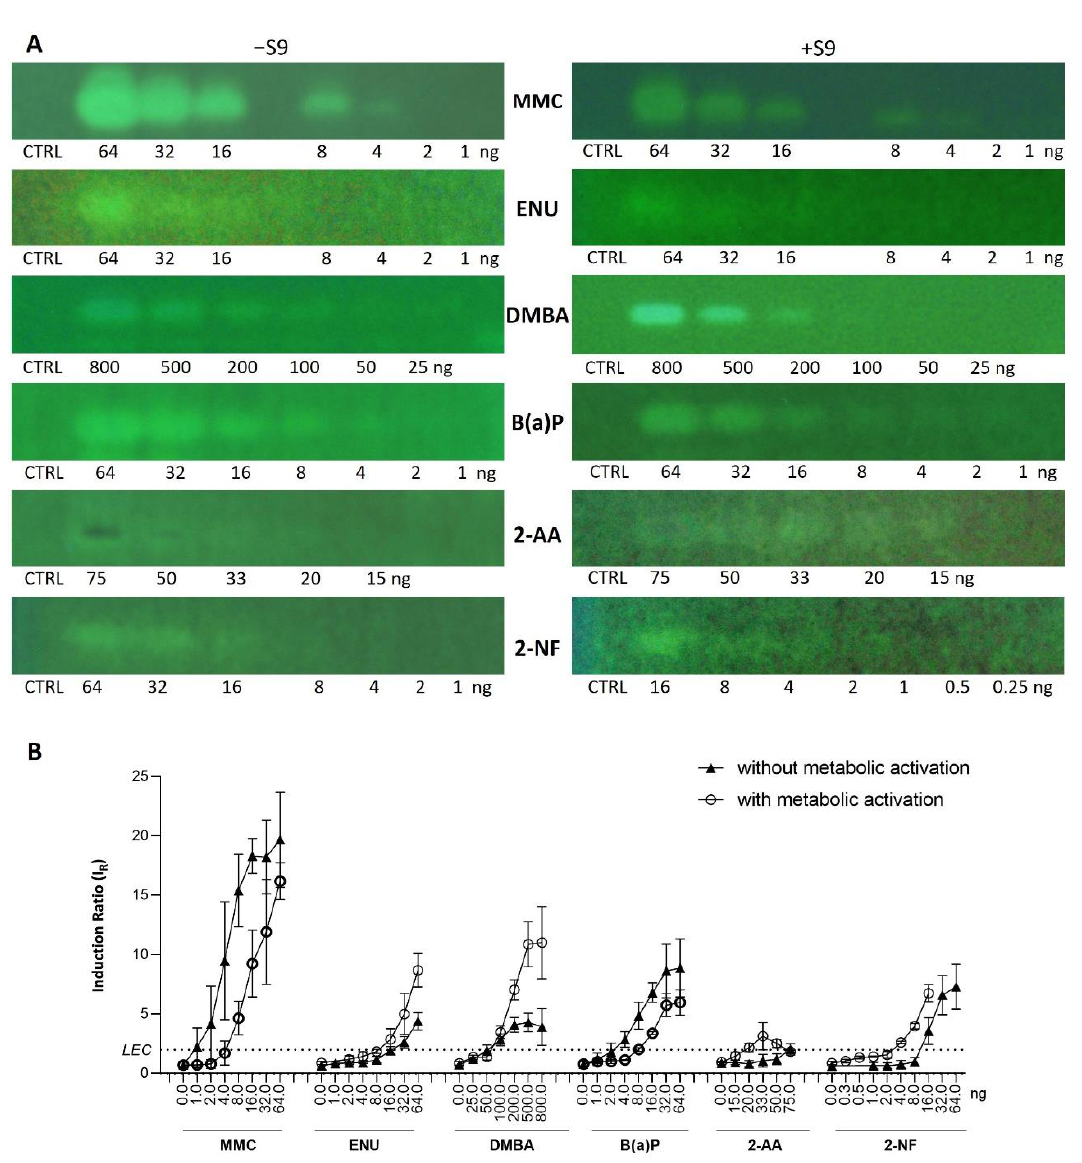
Figure 5. Dose – response study extended to 6 compounds (Table 1) in absence ( − S9) and presence (+S9) of metabolic activation, along with methanol solvent control (CTRL). ( A ) Bioautograms at FLD 254 nm (region of interest shown) and ( B ) dose – response curves with LECs (black dotted line at IR 2.0).